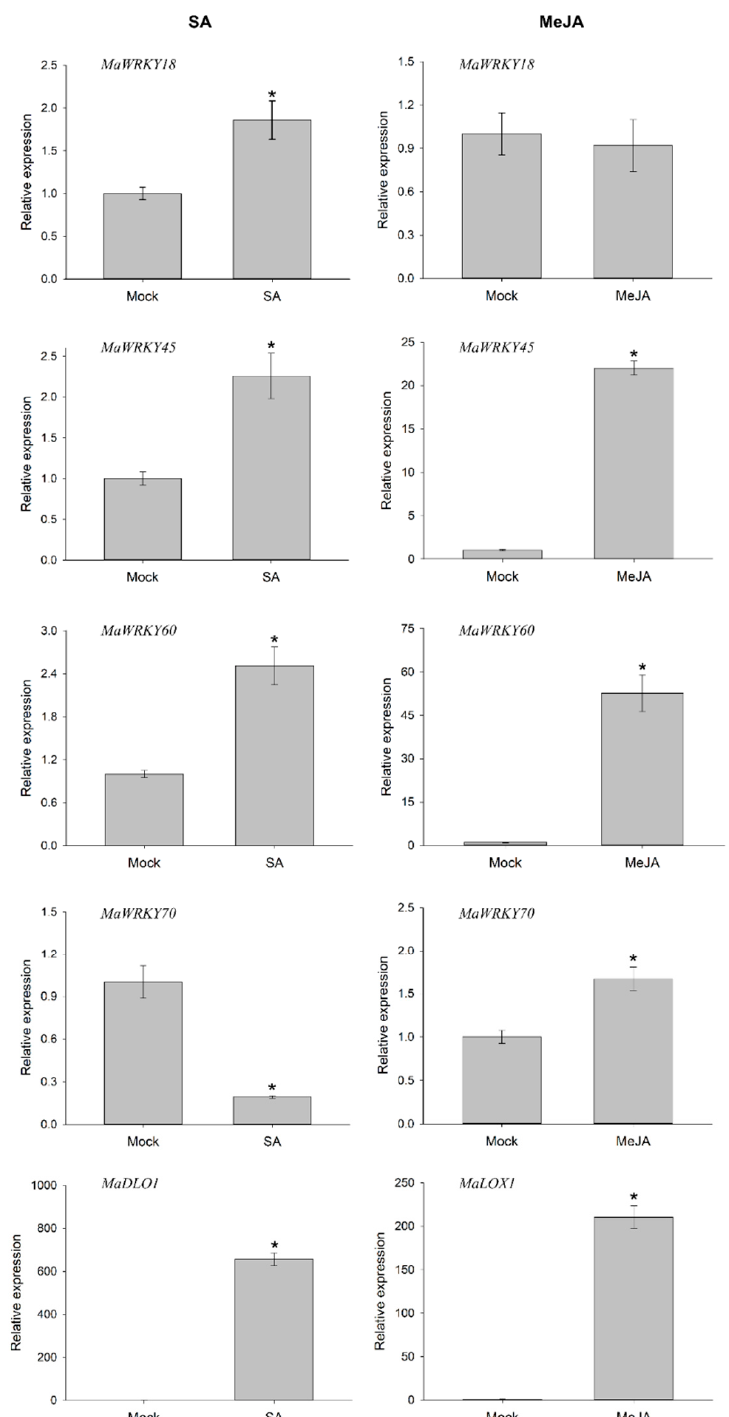
Figure 8. Transcription profiles of MaWRKY18 , MaWRKY45 , MaWRKY60 , and MaWRKY70 genes in response to SA and MeJA phytohormones. A floating disc assay was performed in either SA (5 mM) or MeJA (100 µ M) phytohormones. The leaf discs were incubated for 6 h and collected for total RNA extraction. Gene expression was evaluated by quantitative real-time PCR. The banana 25S gene was used as a reference gene for RT-qPCR analysis. The MaDLO1 and MaLOX1 genes were used as SA- and MeJA-responsive marker genes, respectively. The relative expression value was calculated by the 2 − ∆∆ CT method [43]. The mean ± S.D. of three biological replicates is presented. Asterisks (*) indicate p ≤ 0.05 ( t